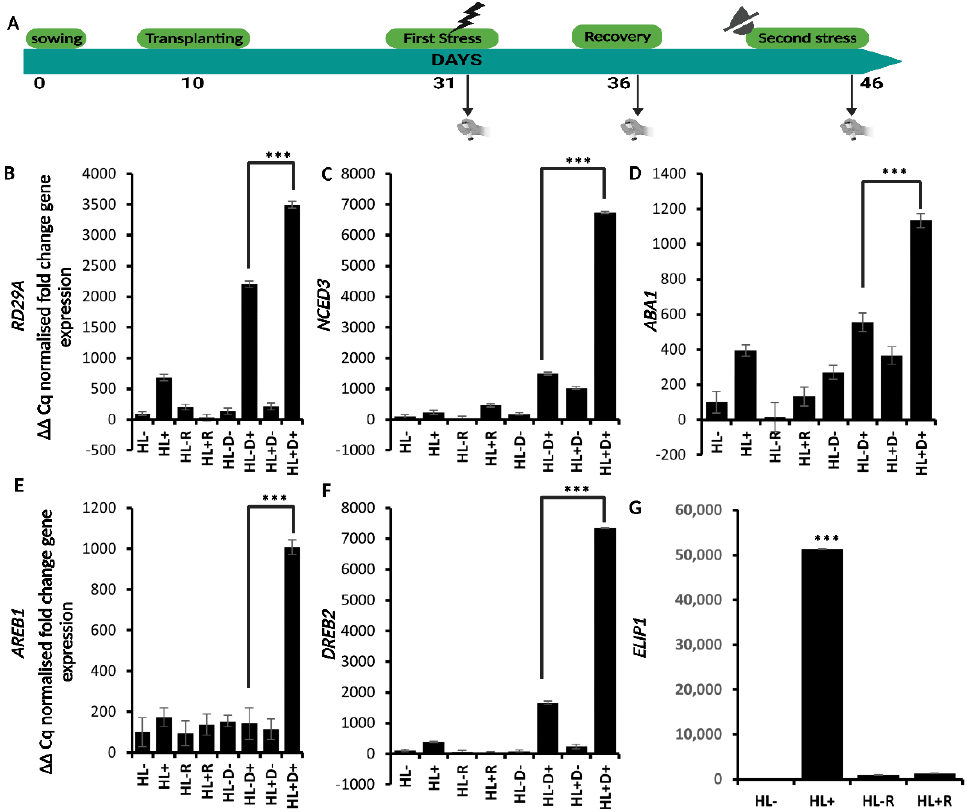
Figure 3. Expression profile of RD29A- and other ABA-responsive genes under sequential stress on WT plants. ( A ) Experimental scheme for subsequential HL and D treatment. ( B – F ) Expression analysis of RD29A , NCED3 , ABA1 , AREB1 , and DREB2 at 3 timepoints (8 conditions). First timepoint: HL- = no HL stress, HL+ = HL-stressed, Second timepoint: HL-R = no HL stress + recovery, HL+R = recovered HL stress, Third timepoint: HL-D- = no HL and D stress, HL-D+ = no HL only D stress, HL+D- = only HL stress no D, HL+D+ = HL and D stressed. ( G ) Expression analysis of ELIP1 only at the first